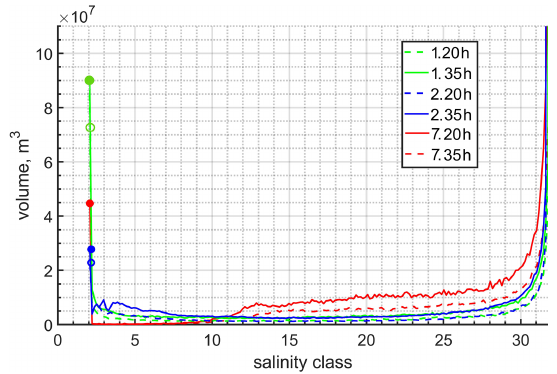
Figure 9. The salinity–volume diagram for runs 1, 2, and 7 at differ- ent time moments. The dashed and solid lines indicate the solutions at 20 and 35h, respectively.